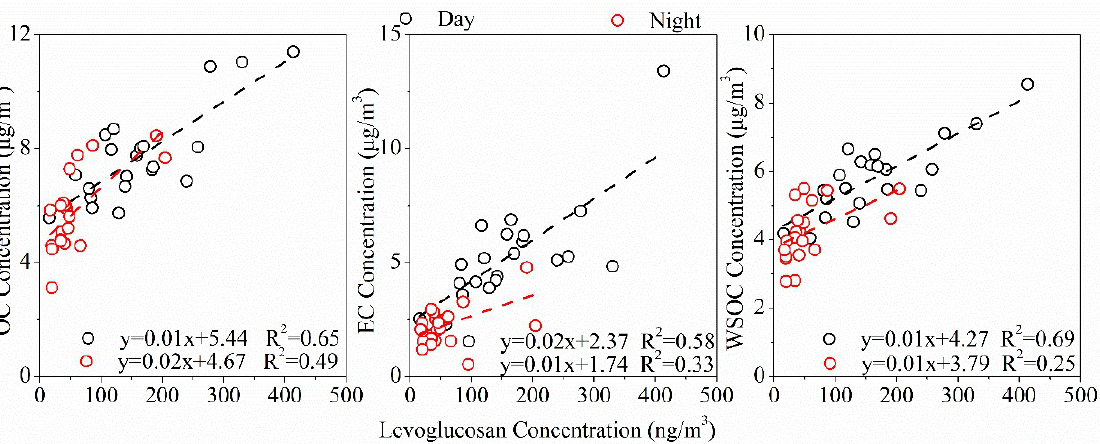
Figure 2. Correlations of OC, EC, and WSOC with levoglucosan in the rural area of Guanzhong Plain, Northwest China. Table 1. Meteorological conditions, PM 2.5 , and chemical component mass concentration during the sampling period.